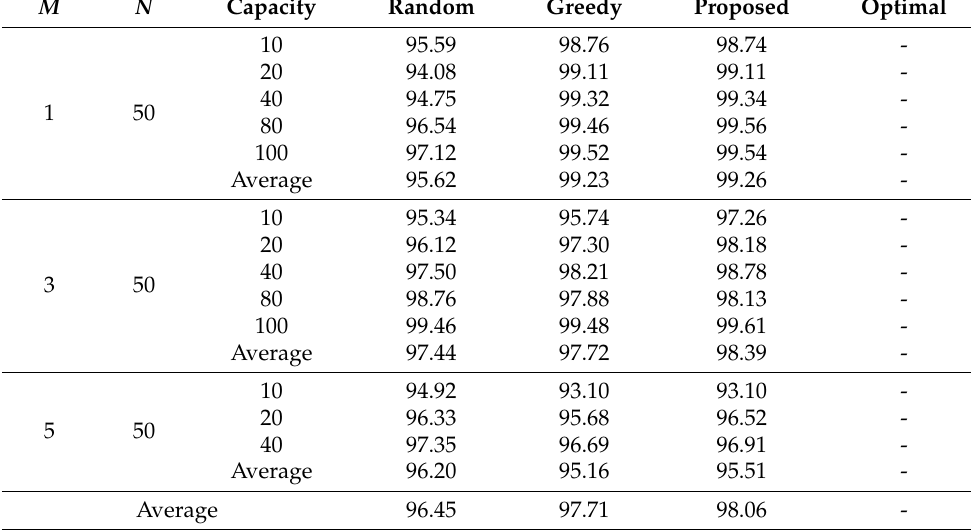
Table 5. The closeness to the optimal solution in LI